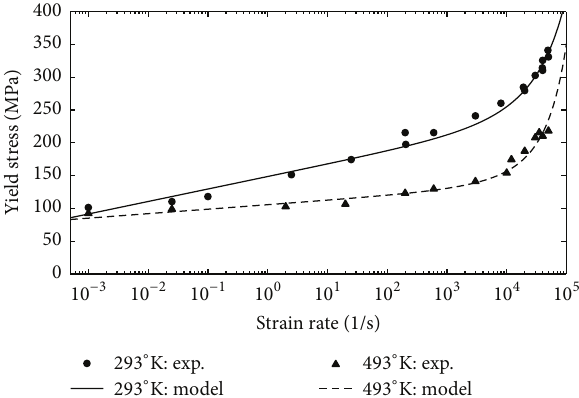
Figure 5: Comparison between experimental data (Clarke et al. [37] and Blazynski [38]) and new modified Eyring equation for annealed mild